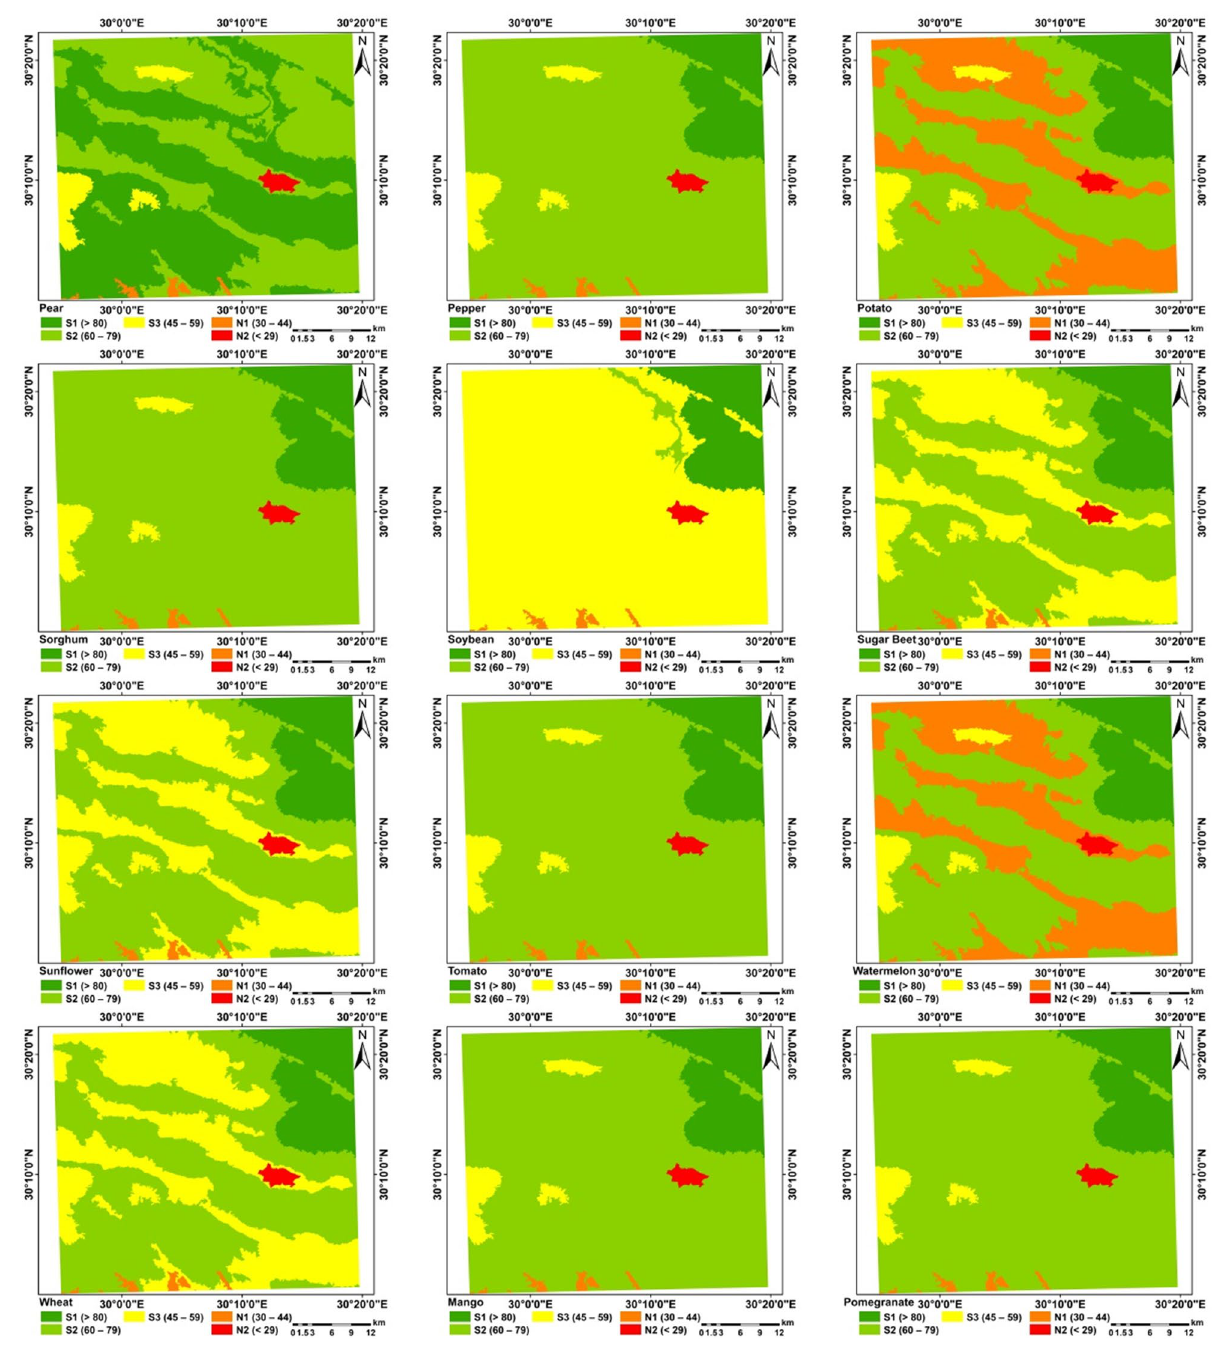
Figure 14. Current/actual crops